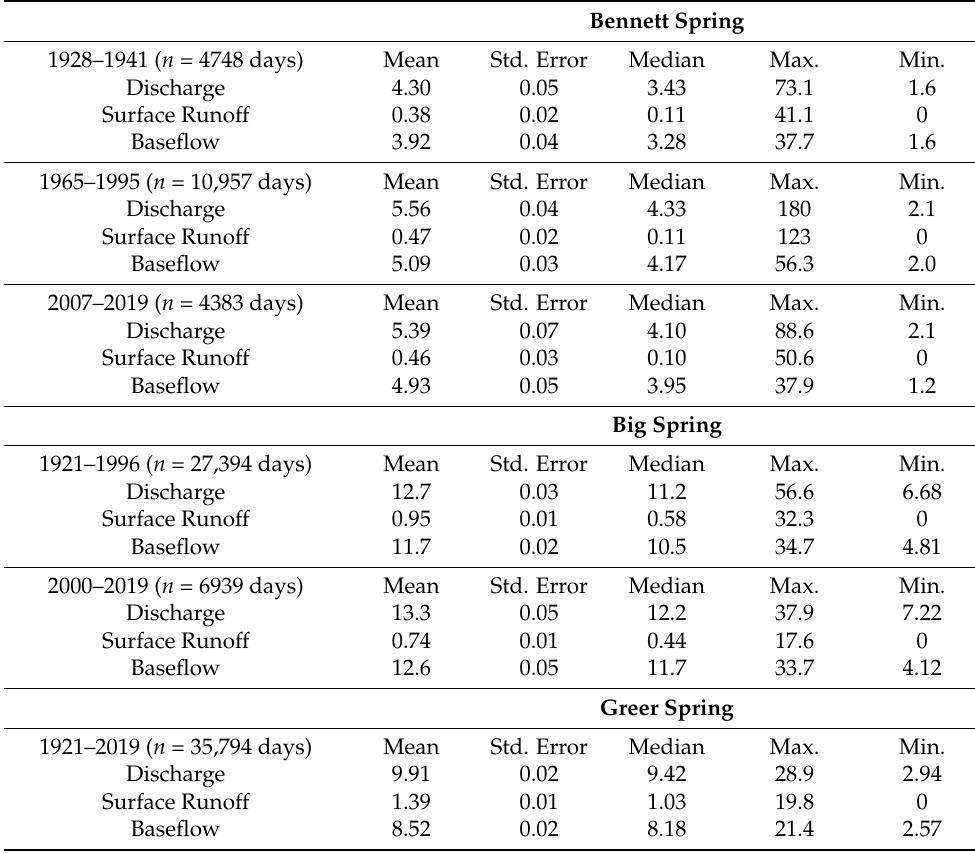
Table 2. Summary statistics for discharge, stormflow, and baseflow (in m 3 /s) for studied springs.